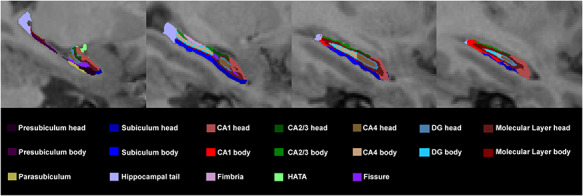
An example of segmentation of hippocampus in one subject.